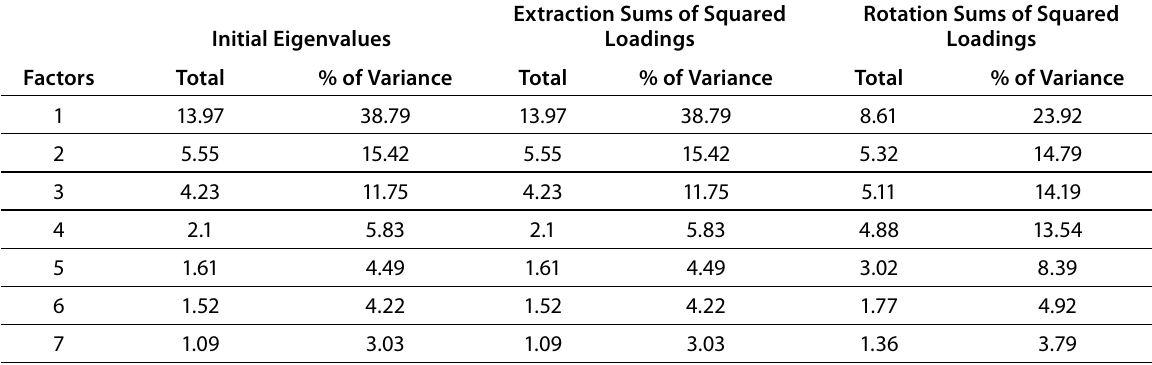
Table 1. Total variance explained by factors